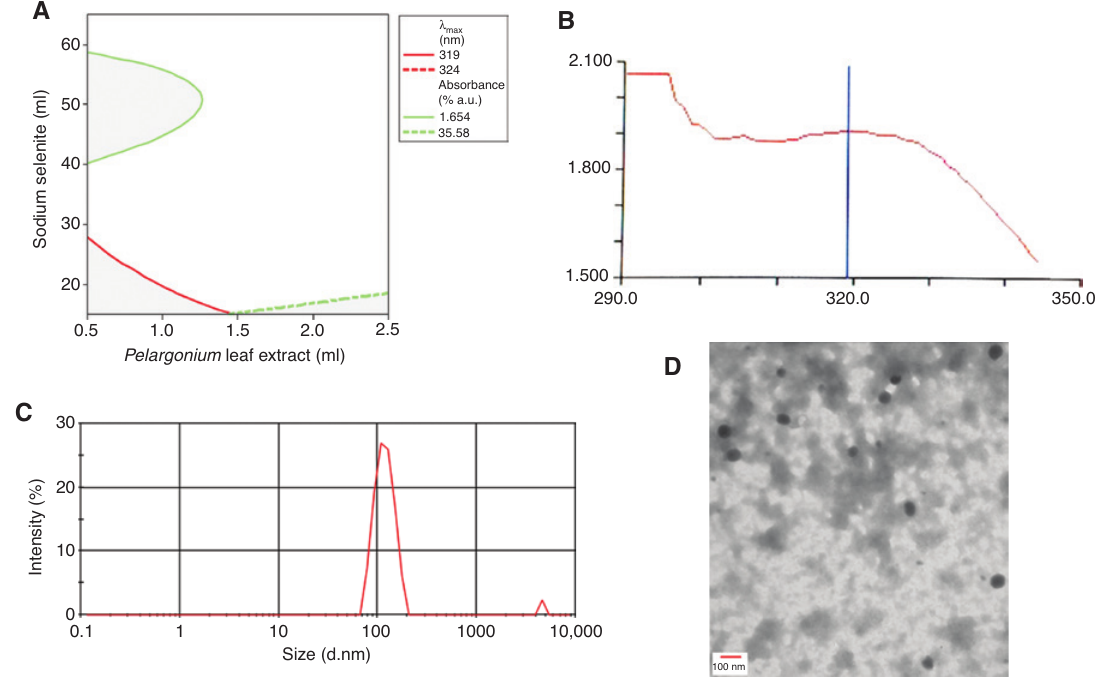
SeO (ml) and Pelargonium zonale 2 3